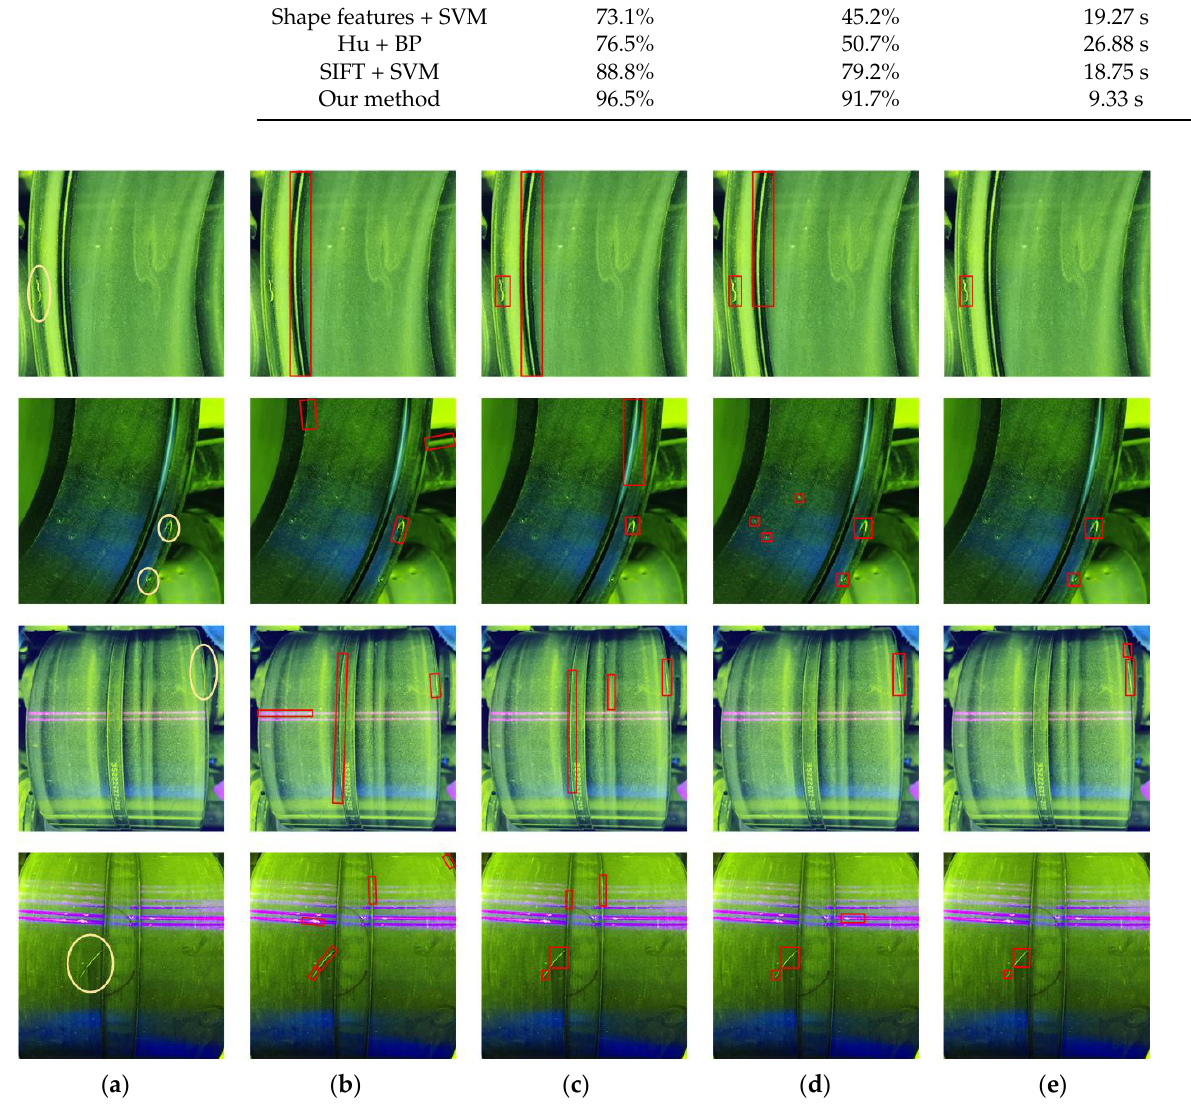
Figure 10. Detection results using four methods. ( a ) Original image; ( b ) The method based on shape features and SVM; ( c ) The method based on Hu moment invariant feature and BP; ( d ) The method based on SIFT features and SVM; ( e ) Our method.